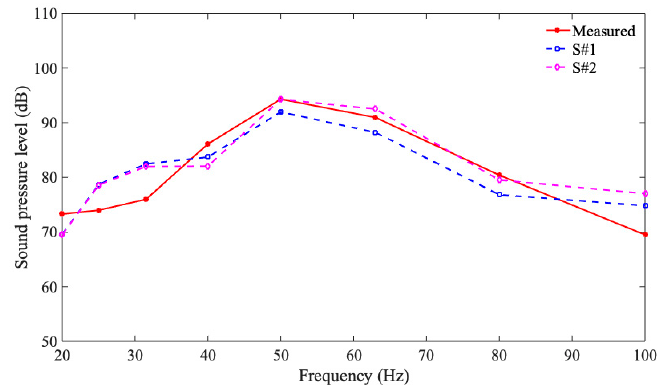
Figure 8. Sound pressure level of P0.